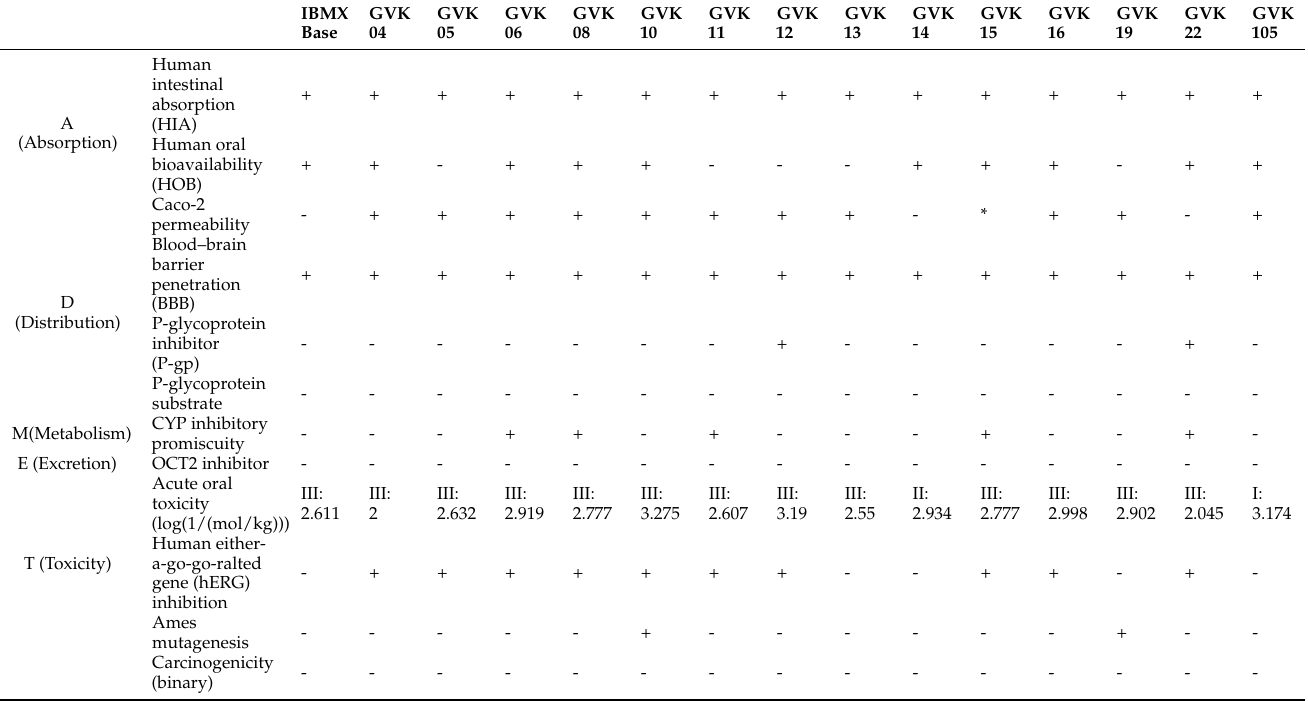
Table 2. ADMET properties prediction of xanthine